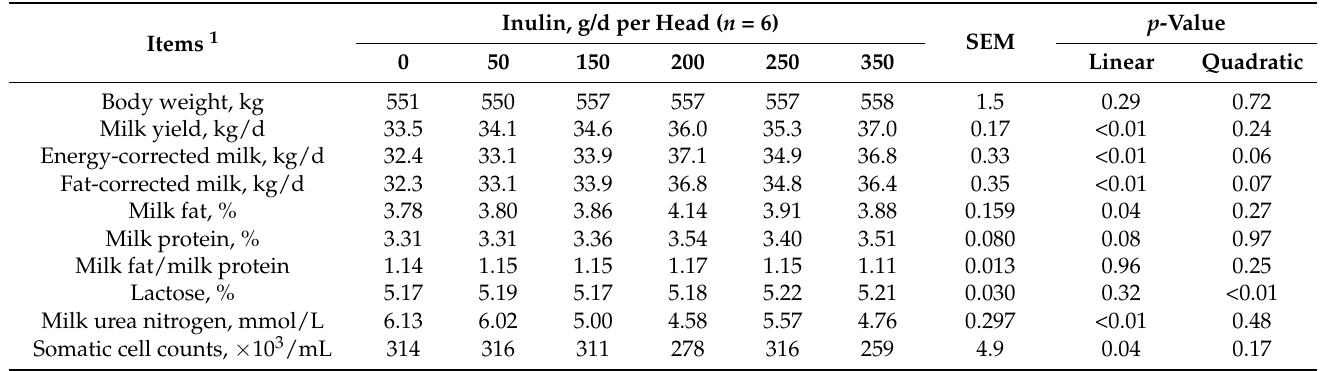
Table 3. Effects of inulin on animal performance and lactation in dairy cows.